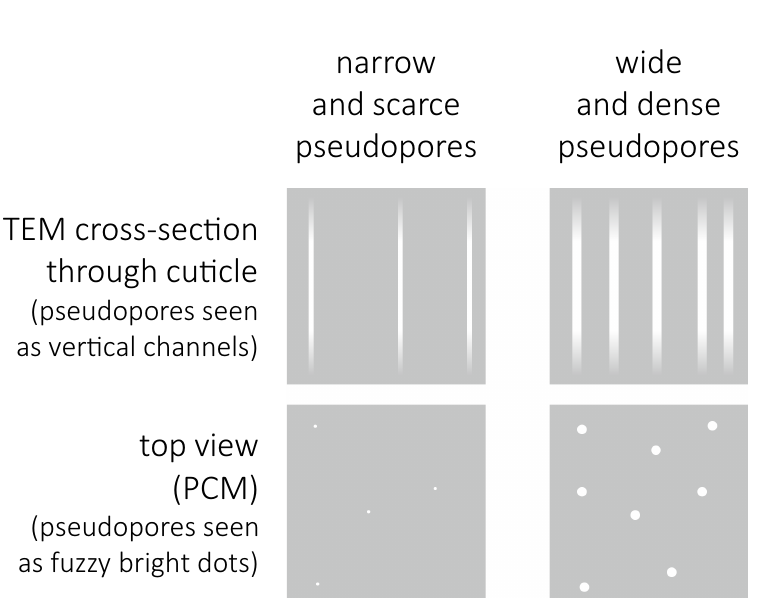
Figure 9. Schematic drawings showing variation in the diameter and density of pseudopores in Milnesium cuticle (based on LCM observations and TEM photomicrographs by 20 ). Small and scarce pseudopores (left panel) are harder to see in LCM than large and densely arranged pseudopores (right panel). The top drawings show cross sections through cuticle, whereas the bottom drawings illustrate a top-down